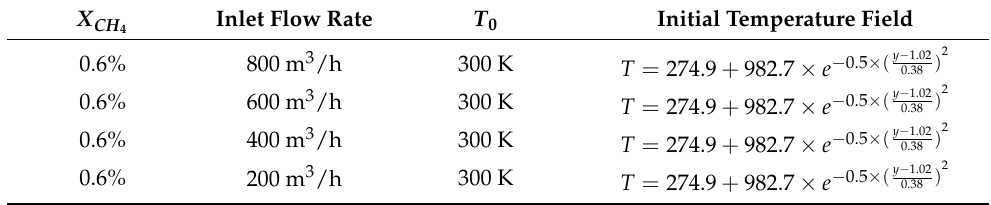
Figure 16. Variation of flame thickness with time at different inlet flow rates with X CH Table 4. Parameters in this